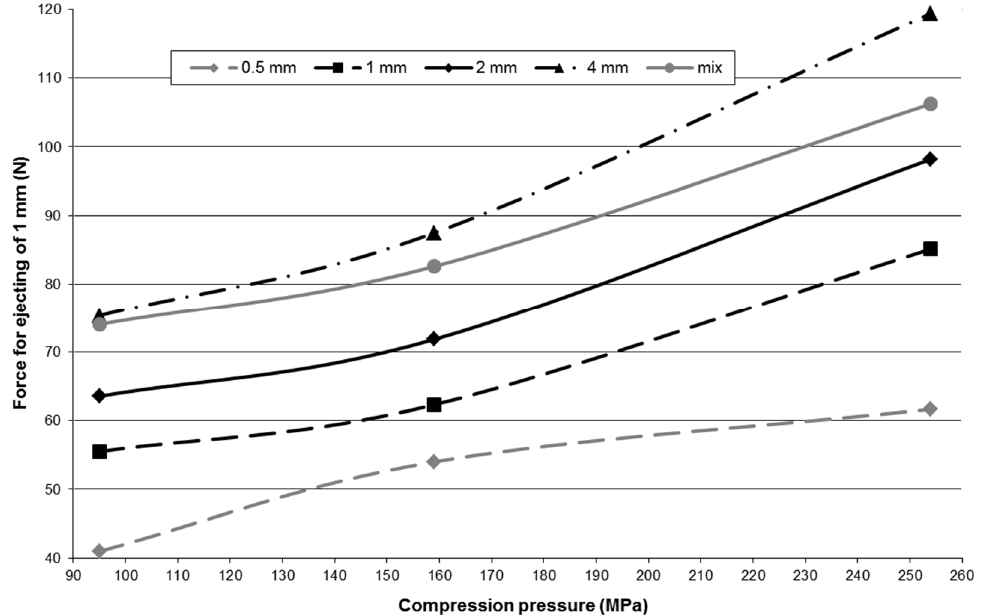
Figure 18. Relation between force needed for ejection and compression pressure for different particle sizes ( w r = 8%; T = 25